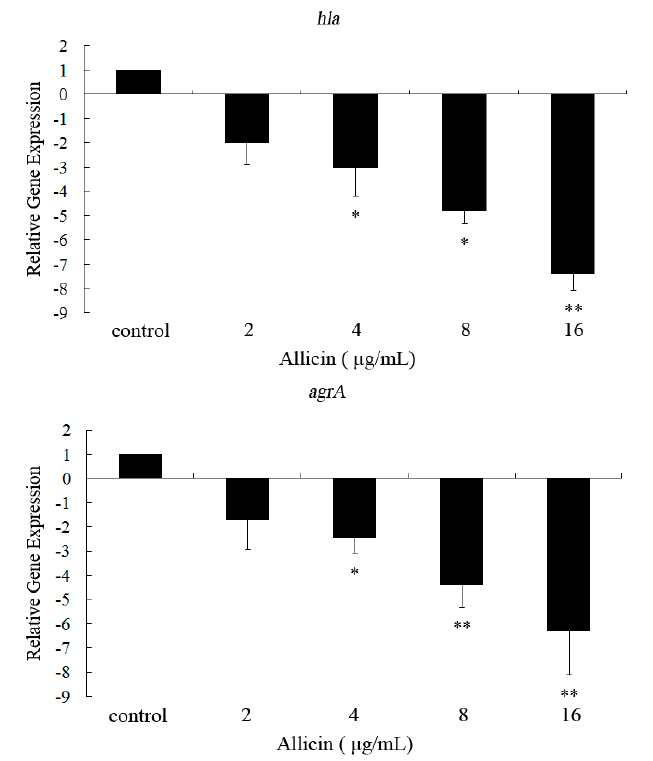
Figure 4. Effects of different concentrations of allicin on the transcription of hla and agrA in S. aureus . Data are expressed as the means ± SD for three independent experiments. The Student’s t-test was used to determine statistical differences. * Indicates p < 0.05 and ** indicates p < 0.01 vs .